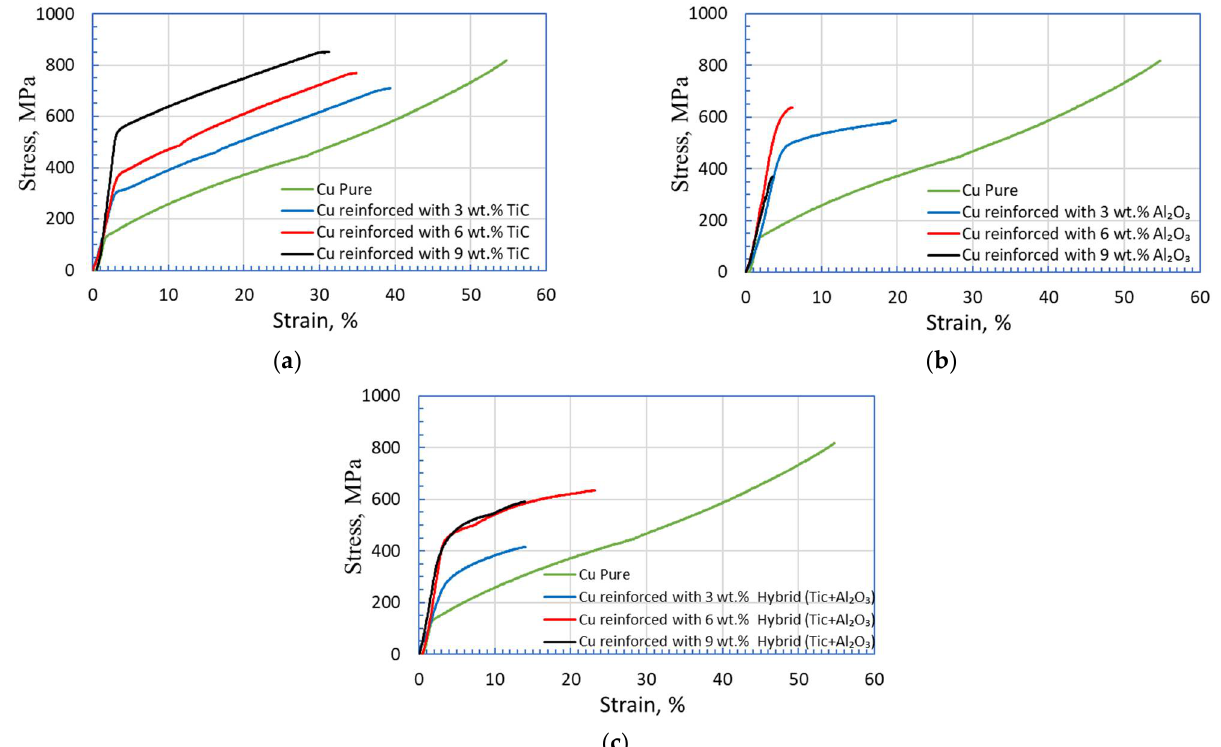
Crystals 2021 , 11 , x FOR PEER REVIEW